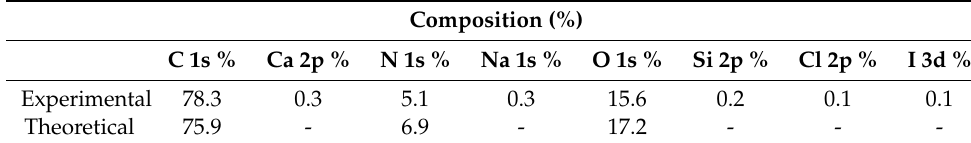
Table 7. XPS elemental composition of cleaned PI film as an atomic percentage.